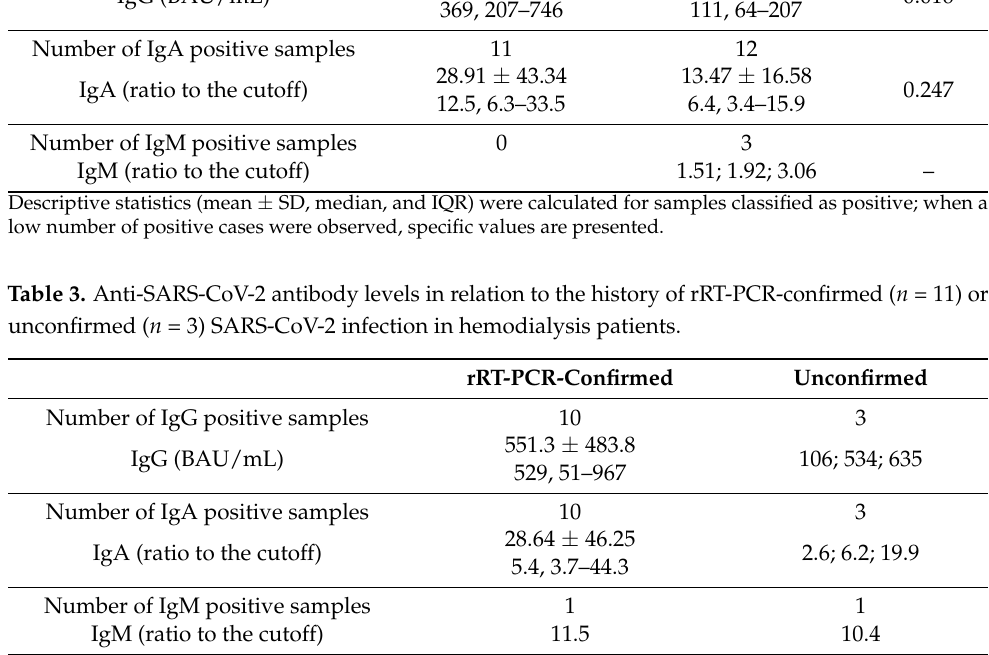
Table 2. Anti-SARS-CoV-2 antibody levels in relation to the history of rRT-PCR-confirmed ( n = 12) or unconfirmed ( n = 13) SARS-CoV-2 infection in kidney transplant patients.